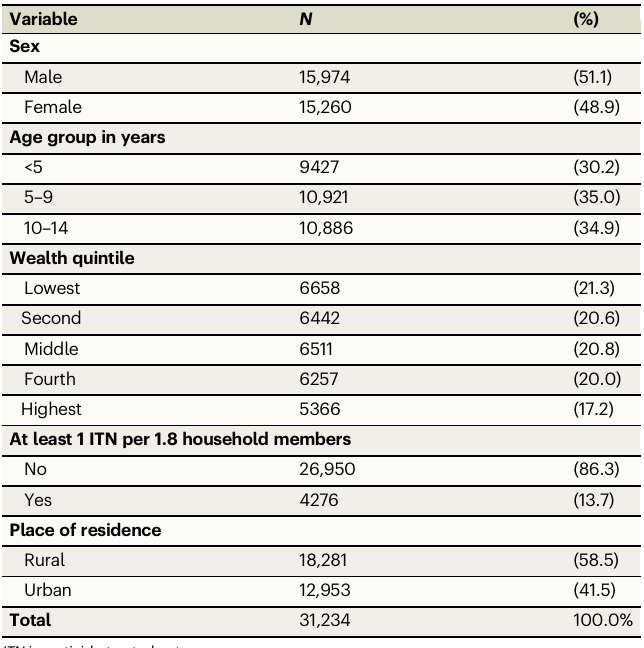
Table 1 | Demographic characteristics for children aged <15 years with malaria laboratory data: Nigeria, 2018